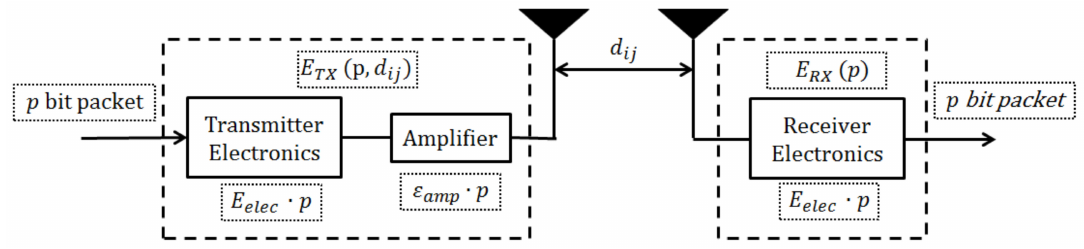
Figure 3. Radio energy dissipation